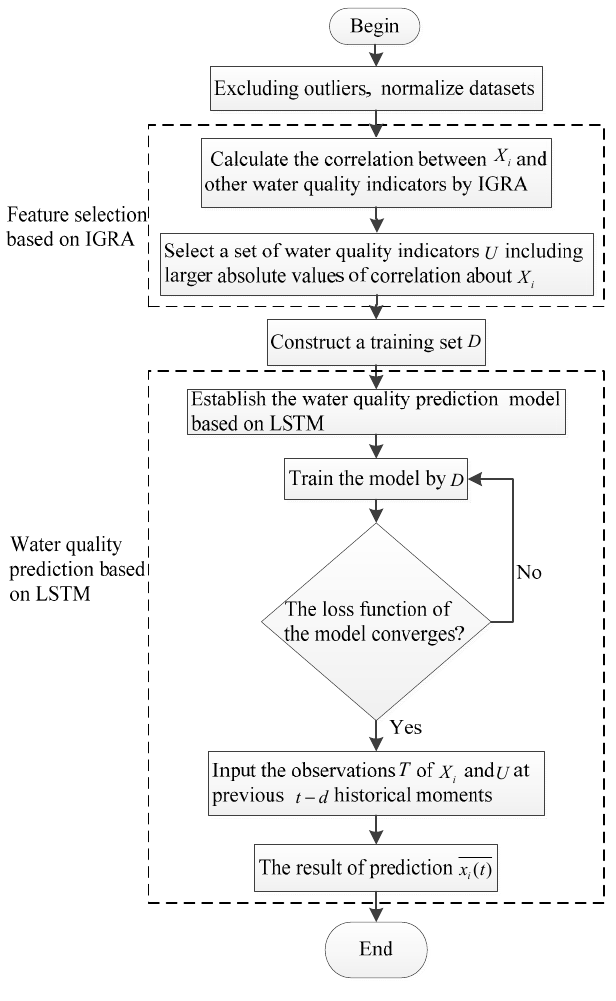
Figure 3. Flow chart of water quality prediction method based on IGRA and